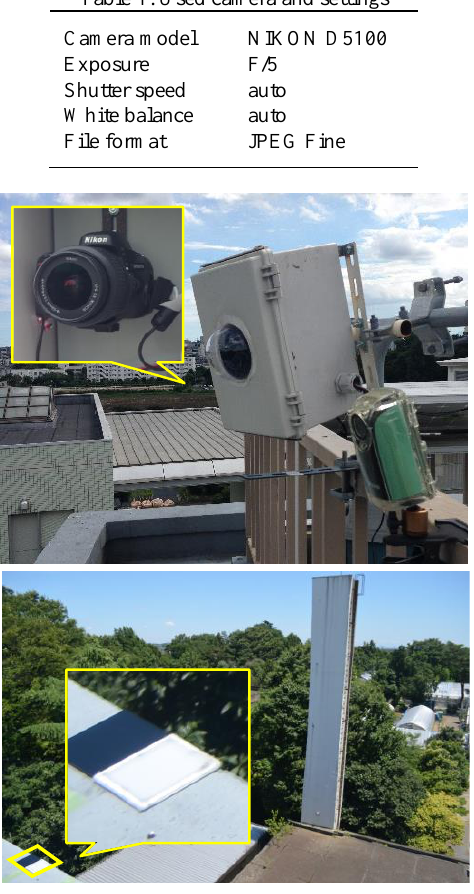
Figure 1. Observation camera and the grayscale board in the